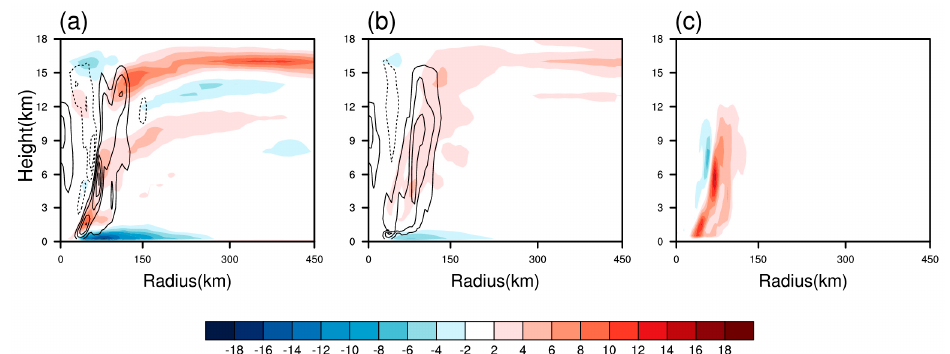
Figure 7. Height-radial cross-sections of the change of azimuthal-mean radial wind (shaded; m s − 1 ) and vertical velocity (contour; m s − 1 ) from hour 24 to hour 48 (i.e., hour 48 minus hour 24) derived from ( a ) the WRF simulation and ( b ) the SE equation diagnoses and ( c ) the change of the diabatic heating field (10 − 3 K s − 1 ) derived from the WRF model from hour 24 to hour 48.